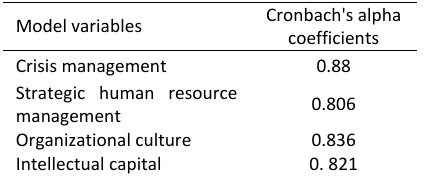
Table 1: Reliability coefficients of the questionnaire variables Table 1. Reliability coefficients of the questionnaire variables